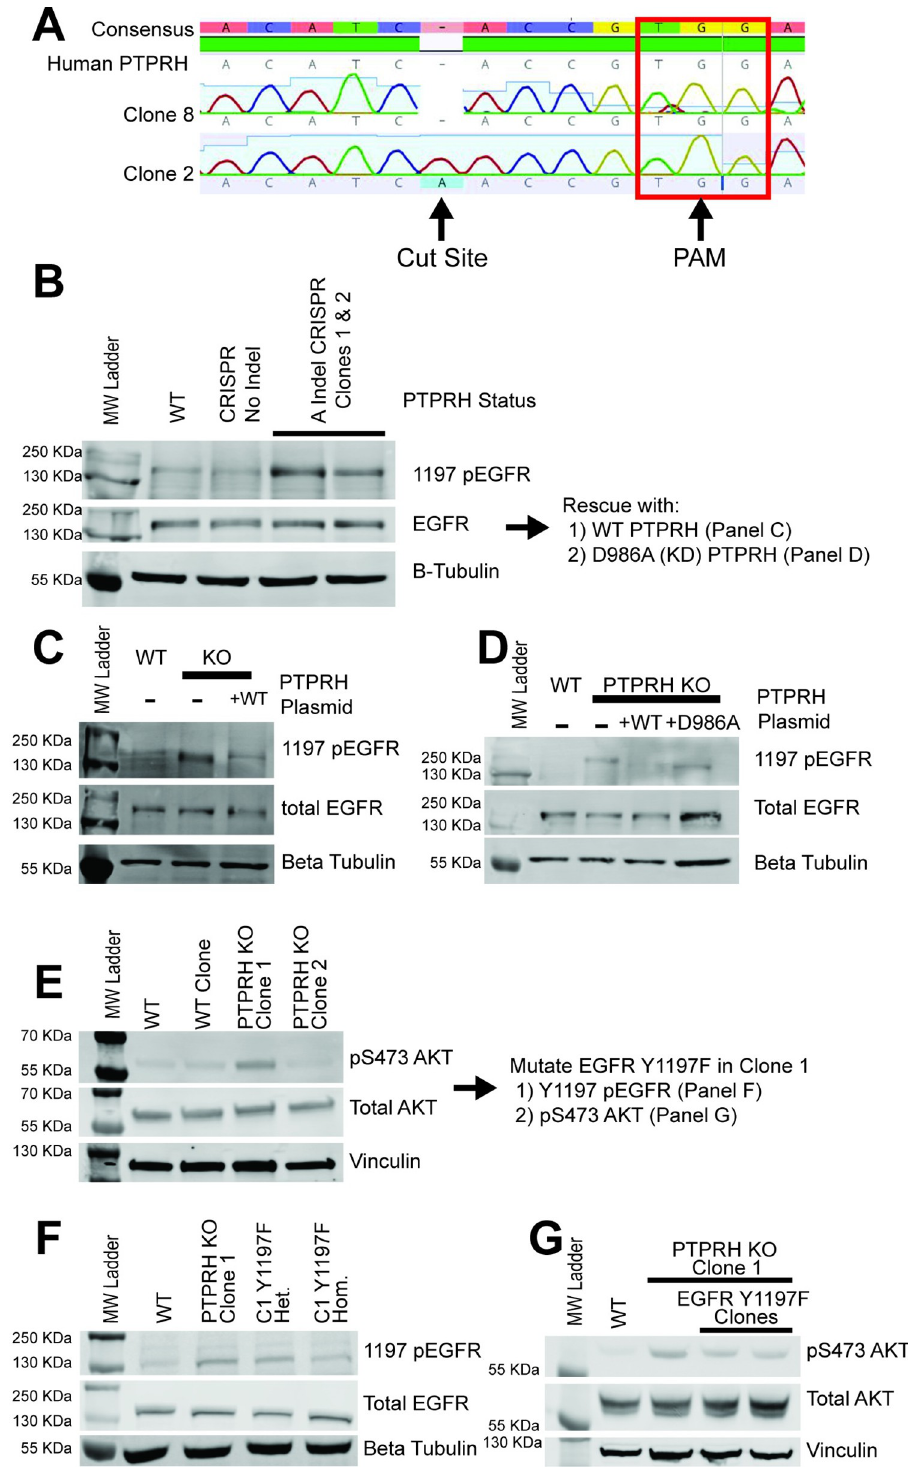
Fig 3. Increased 1197 p-EGFR in H23 PTPRH CRISPR KO Cells. Western blotting using lysate from PTPRH KO cells and PTPRH KO cells with transient overexpression of PTPRH plasmids demonstrates PTPRH indeed targets EGFR within human lung cancer cells. A) Electropherogram of PTPRH KO clones shows an A insertion at the CRISPR cut site. This indel was present for both clones in 3B. B) PTPRH KO CRISPR clones have increased 1197